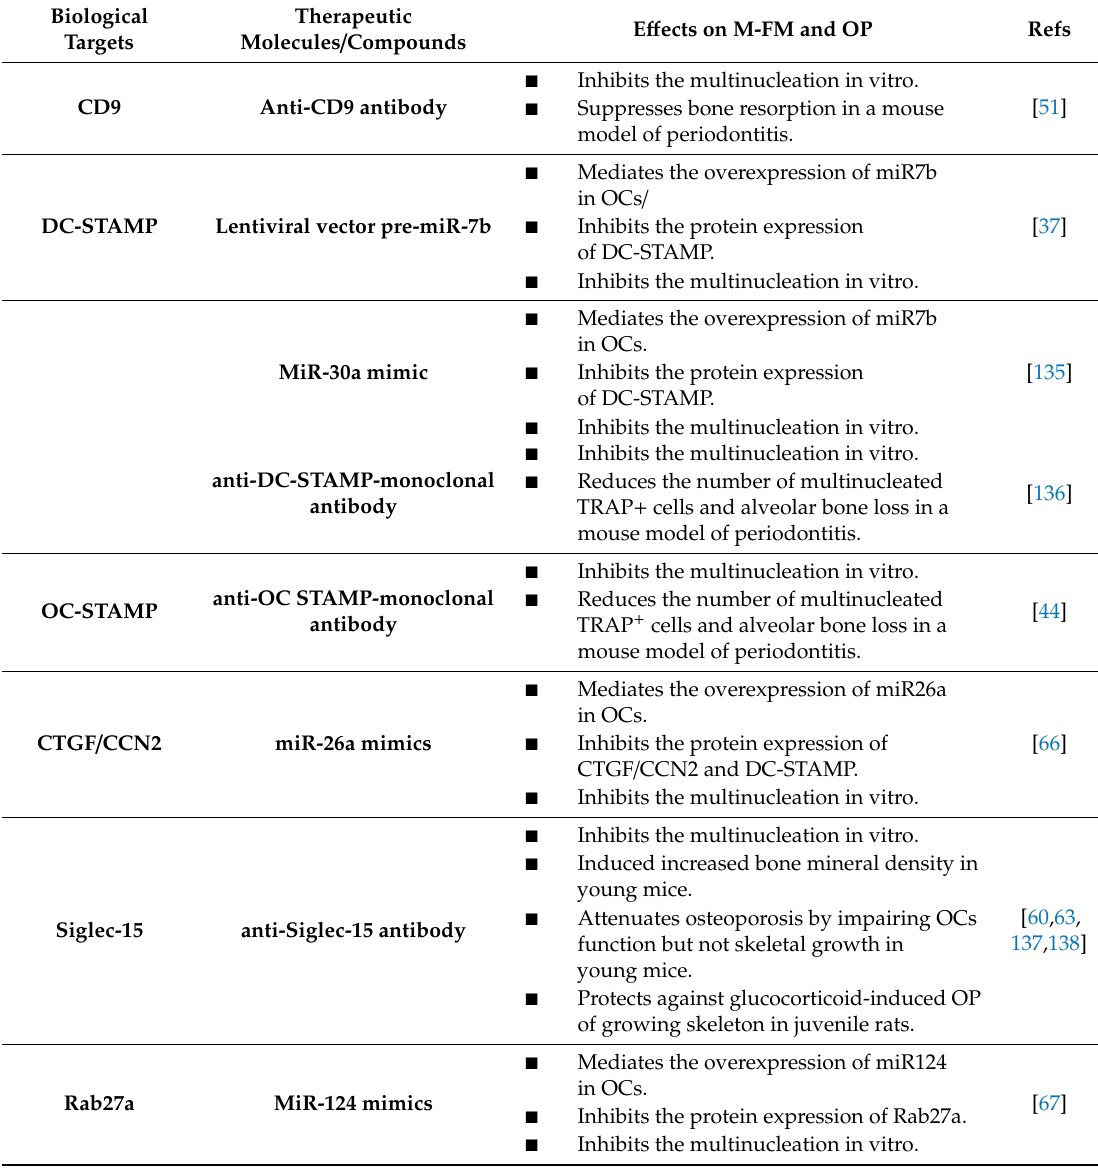
Table 2. Perspectives for osteoporosis (OP) therapy: biological targets for selective inhibition